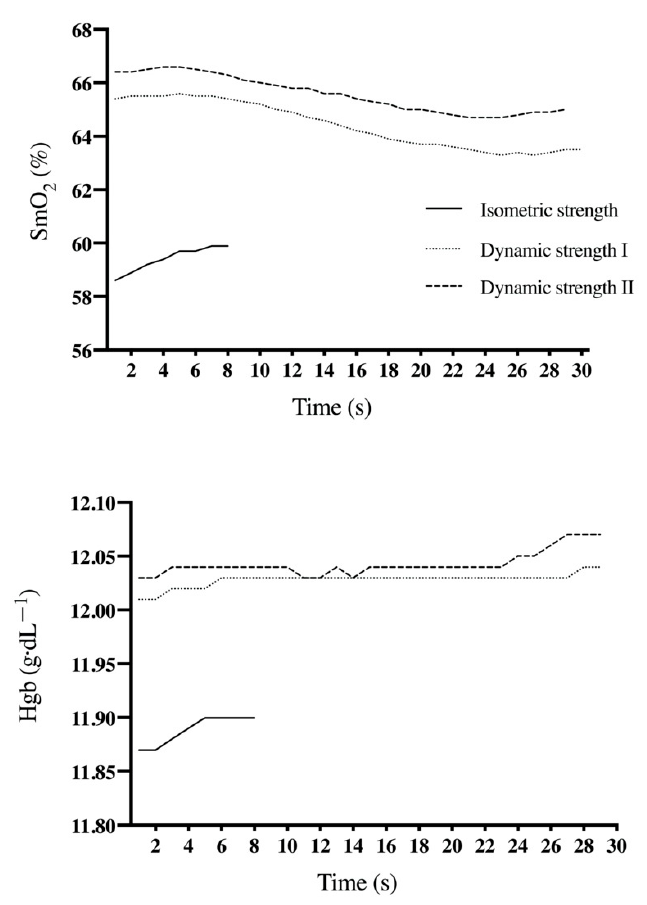
Figure 3. Behavior of SmO 2 and Hgb in a representative individual at rest and during isometric strength and dynamic strength conditions.